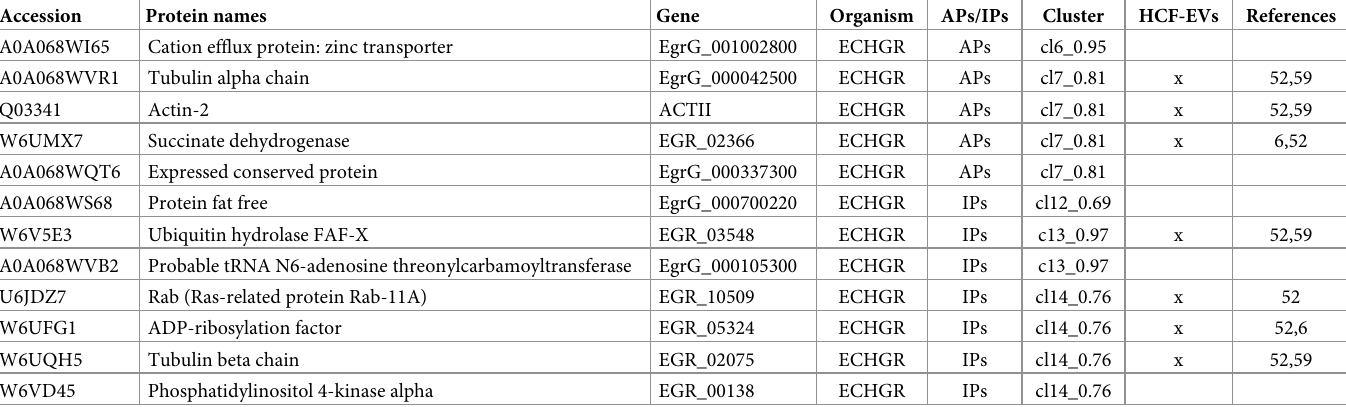
in part the smaller number of specific proteins identified in IPs, and in part probably reflects a lower biological activity in this group than in APs. Of note, all identified E . granulosus proteins (with the only exception of A0A068WS68, Pro- tein fat free, identified only in IPs but found in the double-protein cluster 12) fell in the clusters corresponding to either APs or IPs proteins. The APs E . granulosus proteins (clusters cl6-cl7) were: A0A068WI65, Cation efflux protein zinc transporter; Q03341, Actin-2; A0A068WQT6, Expressed conserved protein; W6UMX7, Succinate dehydrogenase; A0A068WVR1, Tubulin alpha chain. The IPs-selective proteins (clusters cl13-cl14) were: A0A068WVB2, Probable tRNA N6-adenosine threonylcarbamoyltransferase; W6V5E3, Ubiquitin hydrolase FAF-X; U6JDZ7, Rab-11A; W6UFG1, ADP-ribosylation factor; W6UQH5, Tubulin beta chain; W6VD45, Phosphatidylinositol 4-kinase alpha. The annotation of E . granulosus proteins is still poor, but information recovered from the Uniprot (www.uniprot.org [50]) and the Wormbase Parasite (www.parasite.wormbase.org [51]) platforms show that all these proteins are compati- ble with EXO cargo and many were already identified in helminth EVs ( Table 2 ). Finally, we carried out a literature search (which did not attempt to be exhaustive) for previ- ous identifications and annotations of the proteins in our final dataset, concerning exosome and/or CE-related EVs available proteomes. Besides the Top 10, 20 and 100 proteins reported in the Exocarta [49], we examined the last proposed EV characterization based on protein con- tents [28], the proteins involved in exosomes’ release [52, 53], and the proteins identified in previous studies on CE-related EVs [54]. Table 2. List of E . granulosus proteins identified. For each protein the presence in active (APs) or inactive (IPs) samples, the cluster annotation, the previous identifica- tion in EVs from HCF (HCF-EVs) and bibliographic references are reported. Accession Protein names Gene Organism APs/IPs